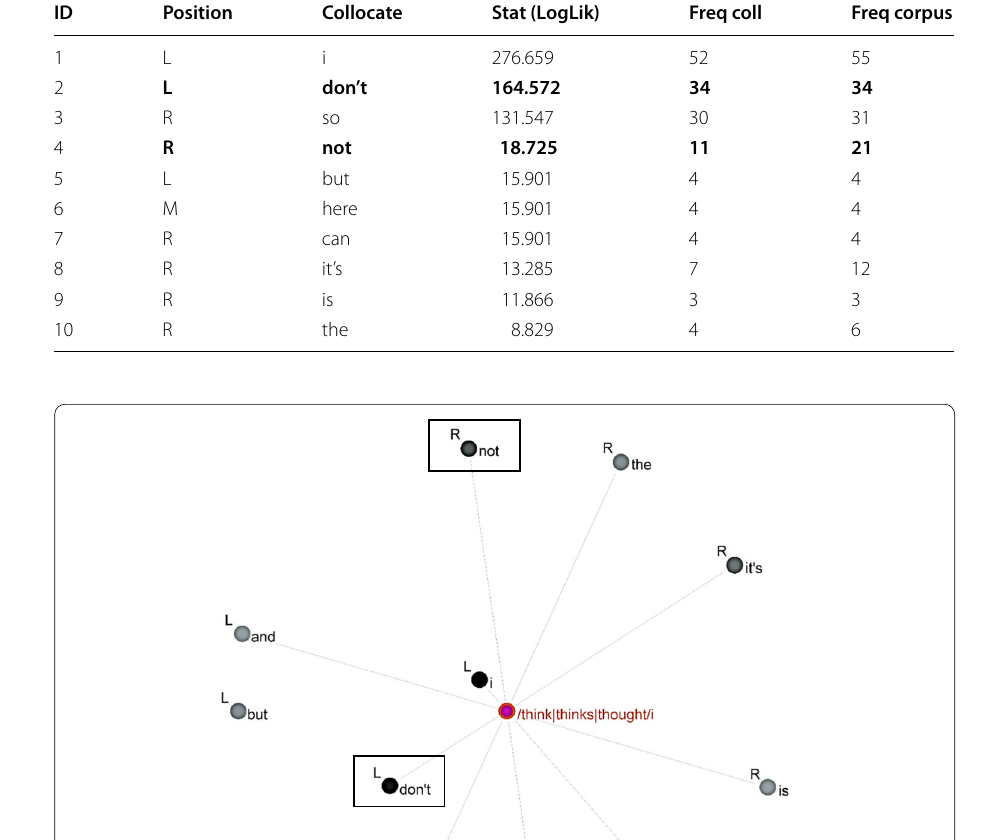
Table 2 Collocates of the search term think|thinks|thought in Easson Corpus of Transferred Negation (06—LogLik (6.63), L5-R5, C: 3.0-NC: 3.0; no filter applied)